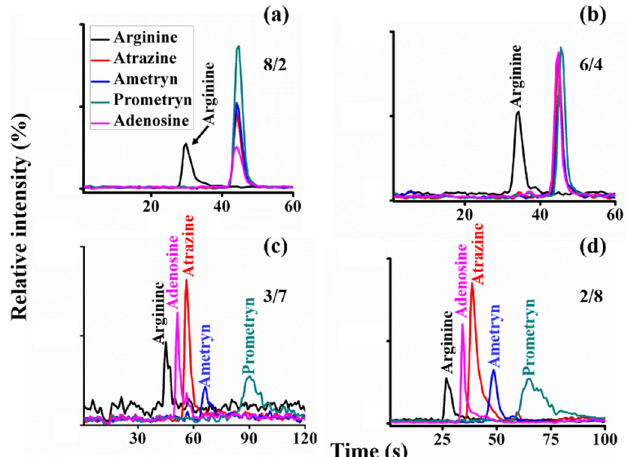
Figure 4. Separation of 5 organics (100 nM) on a C18 wall-coated capillary and on-line for C-API-MS analysis. EICs at m / z 175 (arginine, black curve), 216 (atrazine, red curve), 228 (ametryn, blue curve), 242 (prometryn, green curve), and 268 (adenosine, pink curve) by using acetonitrile/water with different volume ratios: ( a ) 8:2, ( b ) 6:4, ( c ) 3:7, and ( d ) 2:8 as the running buffer in C18 modified fused silica capillary (length: ~3.5 cm). The voltage applied on the inlet of the mass spectrometer was − 4.5 kV.